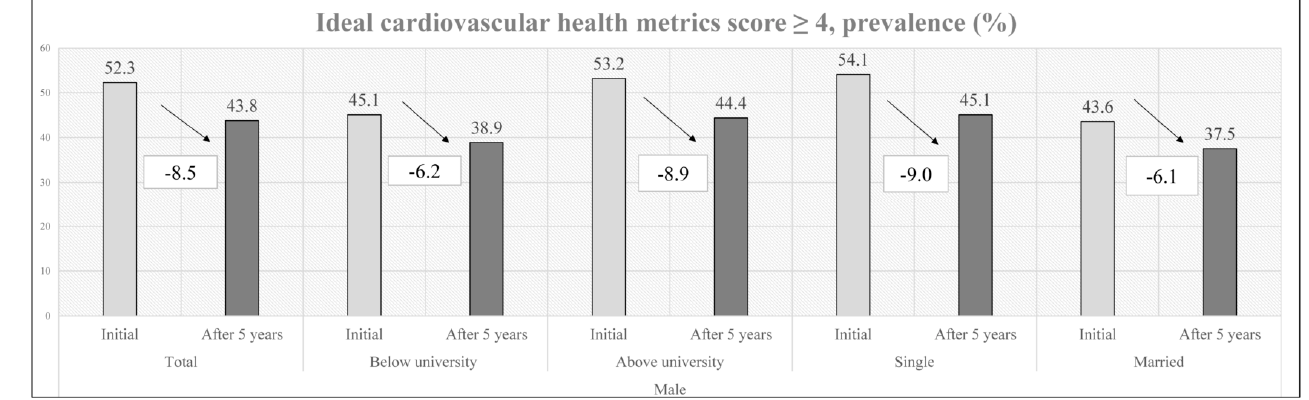
Figure 1. Early changes in males’ CVH metrics by education level and marital status.